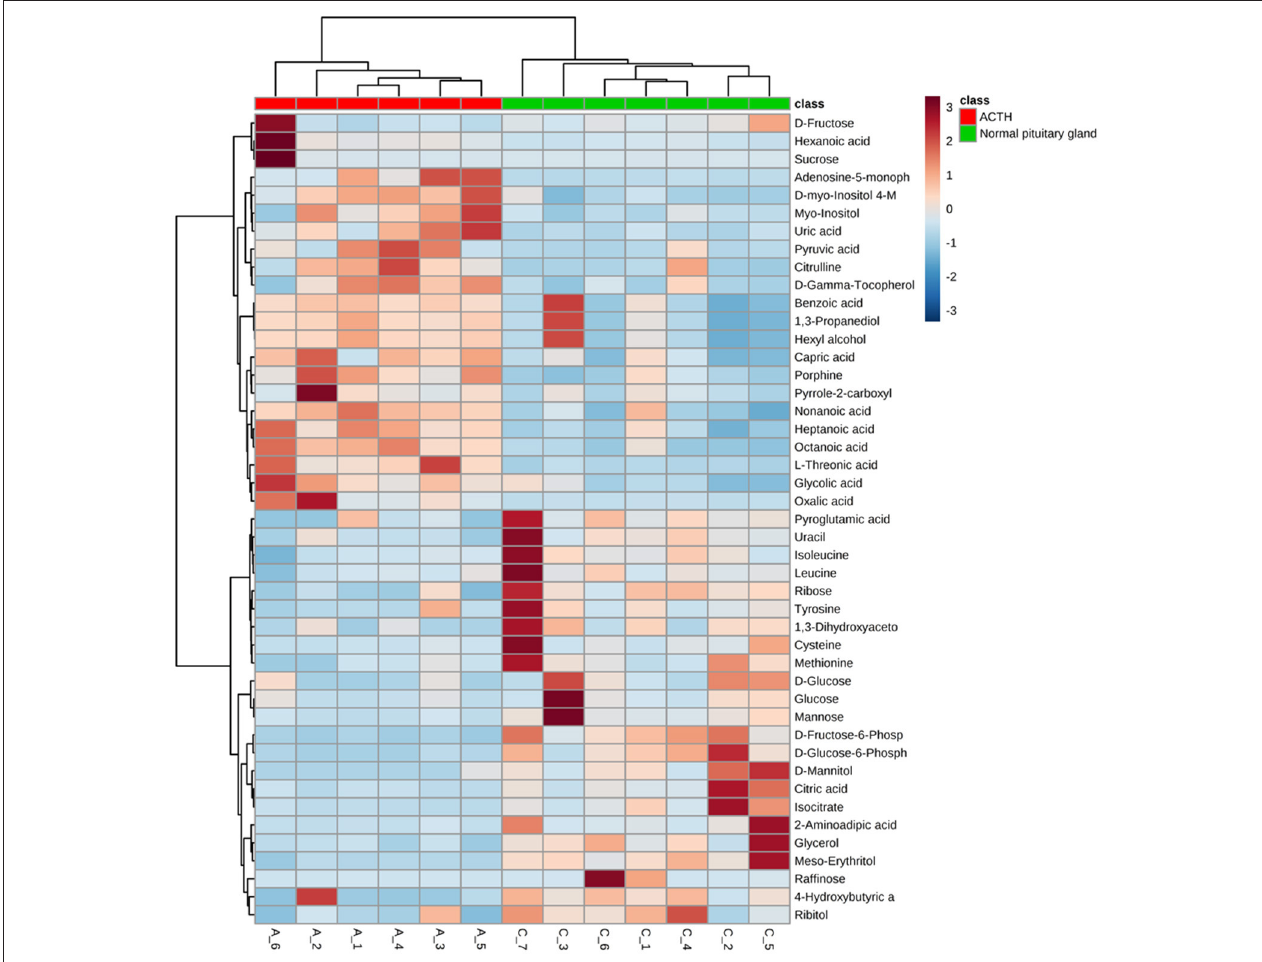
FIGURE 2 | A heatmap illustrating that the 37 metabolites clearly segregate patients with ACTH-PAs and normal pituitary glands. Each colored cell on the map corresponds to a concentration value in the data table, with samples in rows and features/compounds in columns. The heatmap was used to identify samples/features that are unusually